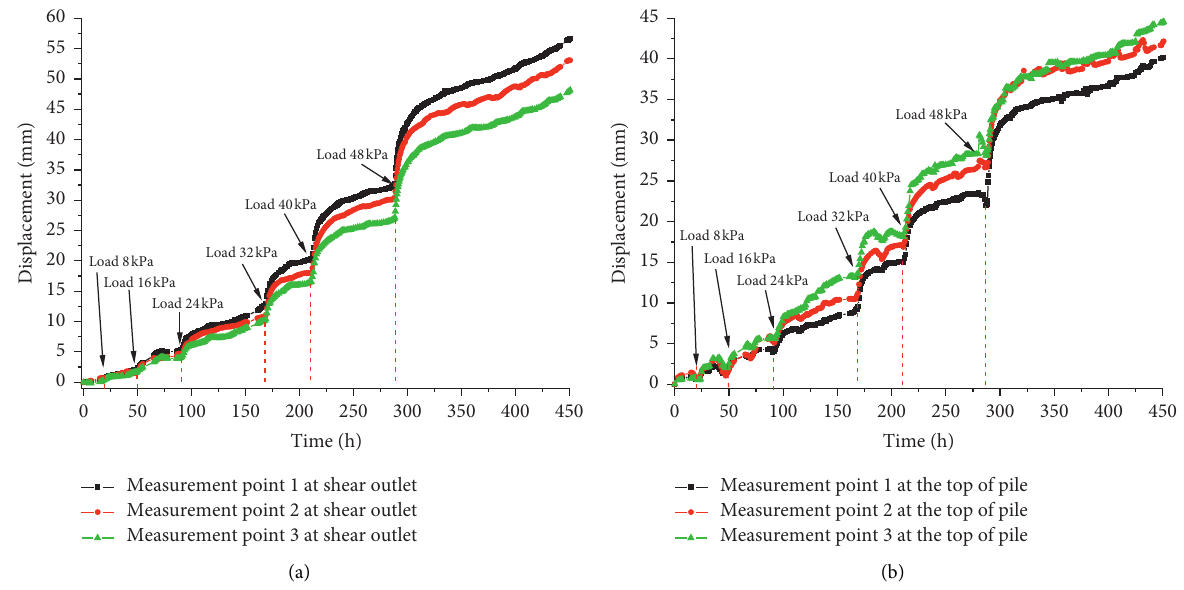
Figure 12: Displacement variation at the monitoring points. (a) Displacement curve at the toe of landslide; (b) displacement curve at the top of